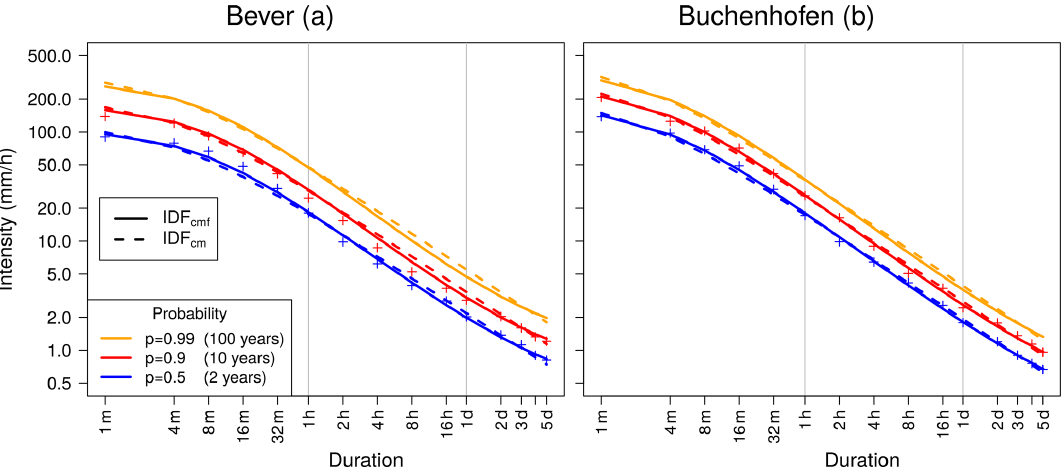
Figure 7. IDF curve for Bever. A comparison of a model with flattening (IDF cmf ) and a model without flattening (IDF cm ). Empirical quantile estimates are denoted with the plus signs ( +